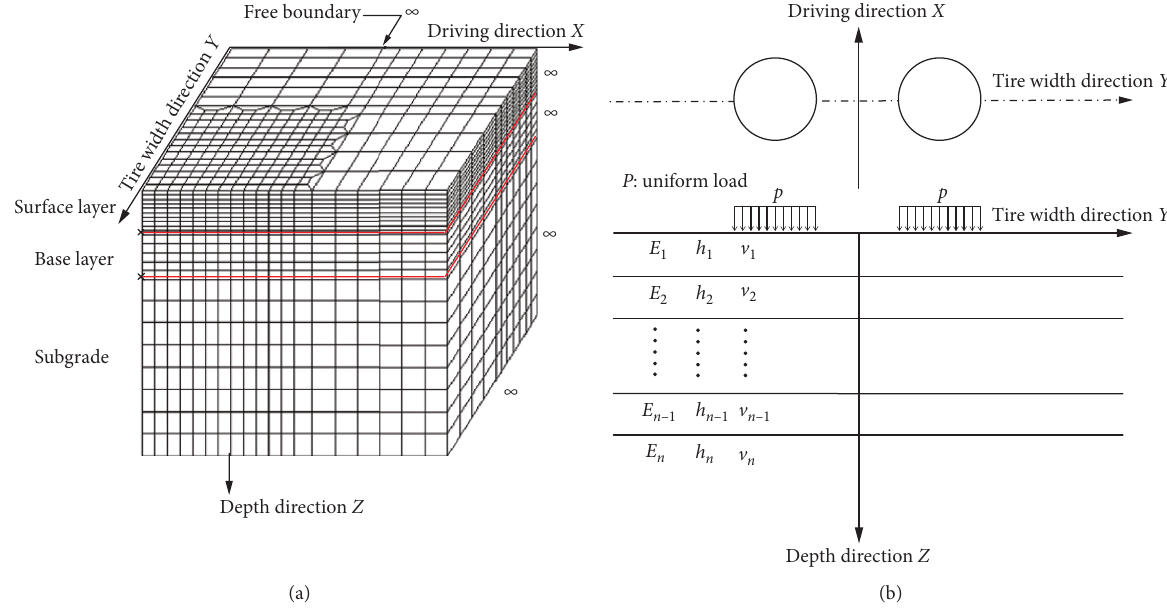
Figure 1: Schematic diagram of two programs of research and development principles: (a) three-dimensional finite element (3D FE); (b) elastic layered system theory.